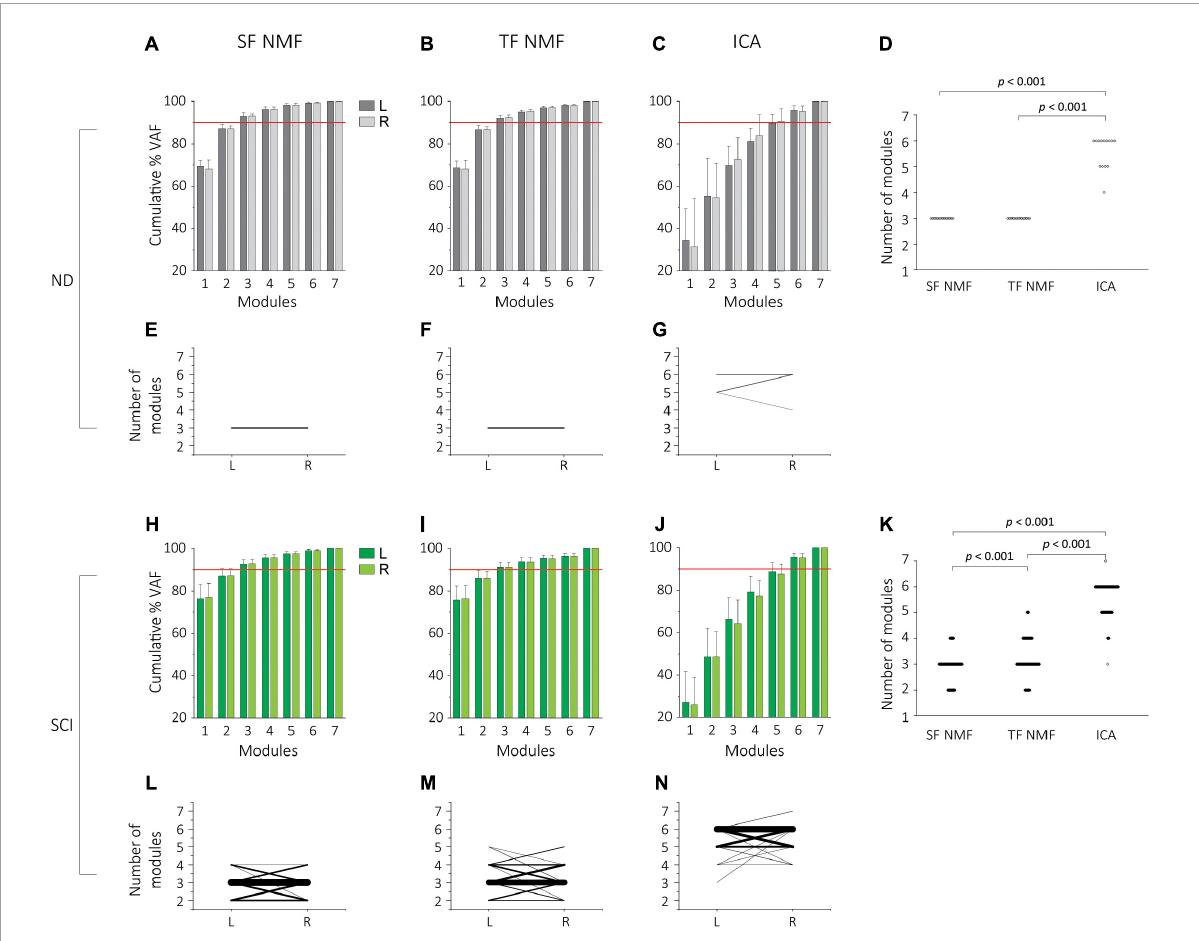
FIGURE1 Cumulative percentage variability accounted for (%VAF) and the number of modules extracted by SF-NMF, TF-NMF, and ICA in NDs and SCIs. (A–G) indicates VAF and the number of modules in NDs ( N = 7, 14 legs), and (H,N) indicates SCI data ( N = 73, 146 legs). (A–C) %VAF (group mean + SD) for left (L) and right (R) legs from SF-NMF (A) , TF-NMF (B) , and ICA (C) in NDs. The horizontal red line indicates 90%. ICA required a greater number of modules to explain 90% VAF in EMGs. (D) Comparison of the number of modules explaining ≥ 90% VAF in the EMG all three analyses in NDs (left and right pooled). Each dot indicates an individual data point. SF- and TF-NMF identified 3 modules in all NDs, whereas ICA identified 4 modules in 1 leg (1 individual), 5 modules in 4 legs (4 individuals), 6 modules in 9 legs (6 individuals). ICA yielded a significantly greater number of modules compared to SF and TF-NMF to explain ≥ 90% VAF in NDs ( p < 0.001). (E-G) The number of left and right modules in NDs, identified by SF-NMF (E) , TF-NMF (F) , and ICA (G) . Each line represents left-right pair for each subject. Thicker lines represent a greater prevalence of the pair. All subjects had 3 modules bilaterally from SF- and TF-NMF, whereas only 3 ND subjects had the same number of modules (Bizzi et al., 2000) bilaterally in ICA. The number of modules between left and right legs was not statistically different. (H-J) %VAF (group mean + SD) for left (L) and right (R) legs from SF-NMF (H) , TF-NMF (I) , and ICA (J) in SCIs. Similar to the NDs, ICA required a greater number of modules to explain 90% VAF in SCIs. (K) Comparison of the number of modules explaining ≥ 90% VAF in the EMG all three analyses in SCIs. SF-NMF yielded 2 modules in 32 legs (25 individuals), 3 modules in 97 legs (64 individuals), and 4 modules in 17 legs (16 individuals). TF-NMF yielded 2 modules in 19 legs (15 individuals), 3 modules in 85 legs (56 individuals), 4 modules in 35 legs (29 individuals), and 5 modules in 7 legs (7 individuals). ICA yielded 3 modules in 1 leg (1 individual), 4 modules in 7 legs (6 individuals), 5 modules in 44 legs (36 individuals), 6 modules in 92 legs (61 individuals) and 7 modules in 2 legs (2 individuals). ICA resulted in a significantly greater number of modules than SF- and TF-NMF in SCIs, and TF-NMF resulted in a greater number of modules than SF-NMF ( p < 0.001). (L-N) The number of left and right modules in SCIs, identified by SF-NMF (L) , TF-NMF (M) , and ICA (N) . Each line represents left-right pair for each subject, and thicker lines represent a greater frequency of the pair. The number of modules between left and right legs was not statistically